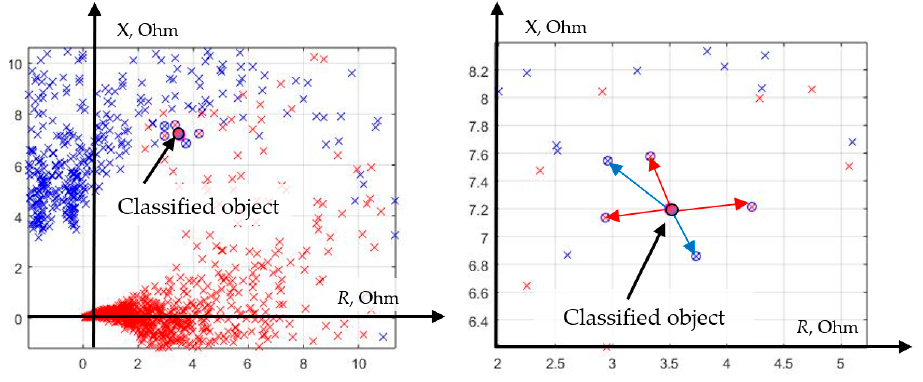
Figure 5. Classification of sample resistance value in feature space [26].